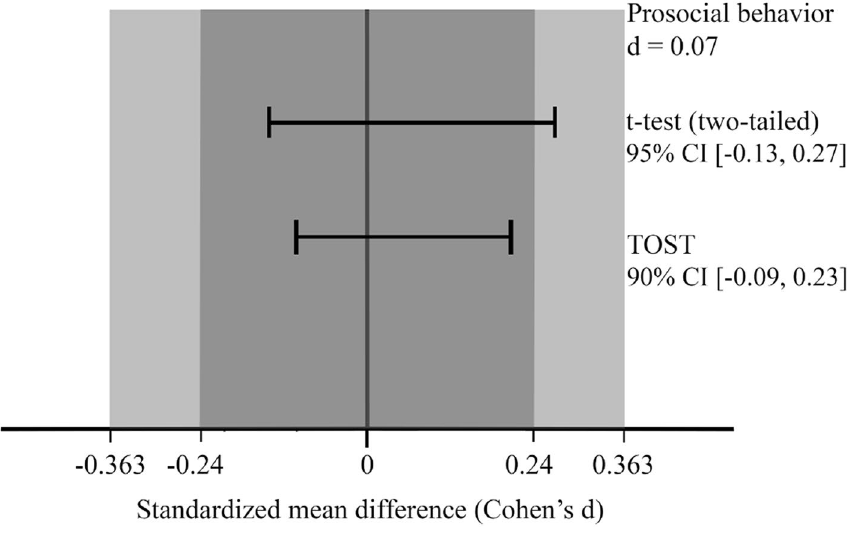
Figure 2. Standardized mean differences for the ‘Mask’ group and the ‘No Mask’ group in Study 1. Note The t-test indicates that the difference between the two groups is non-significantly different from 0. The TOST indicates that the difference between the two groups is significantly smaller than d = 0.363 and smaller than d =